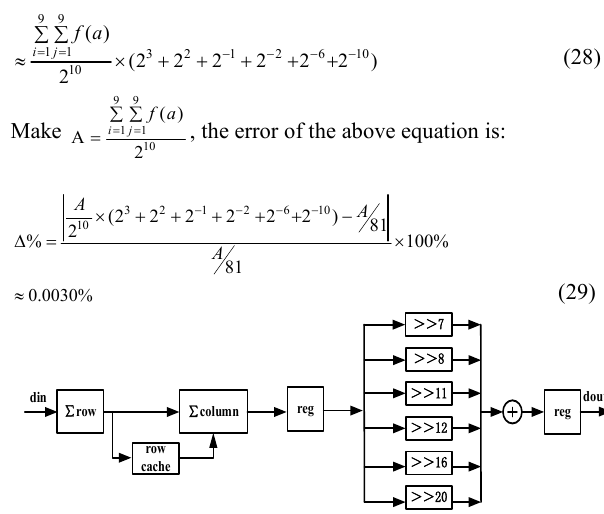
Figure 11. Mean value calculation module of 9×9 image based